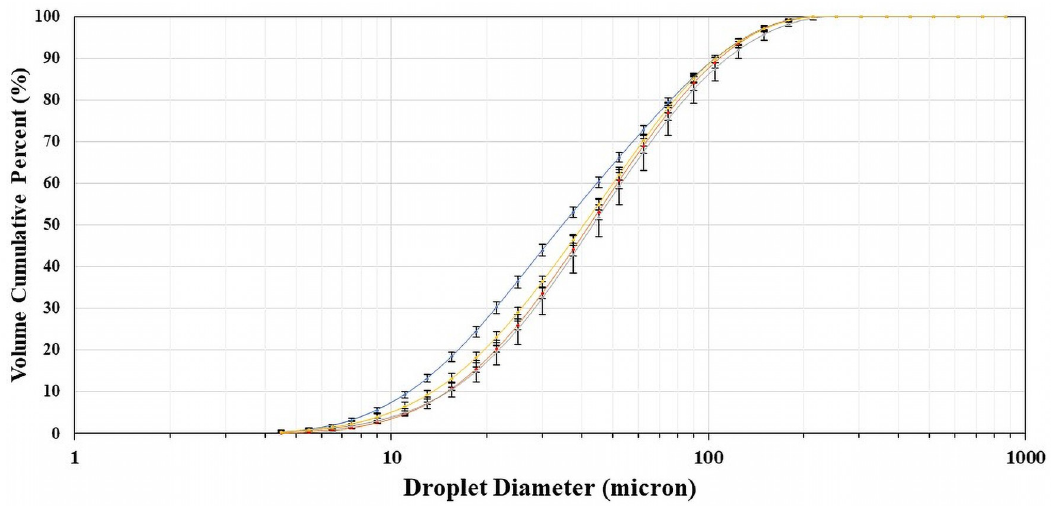
Fig 2. Cumulative size distributions by volume for the total 360 sprayer, at 6-foot distance, when spraying different liquids. Blue line = deionized water; red line = tap water; Grey line = disinfectant with dichlor as the active ingredient; Yellow line = disinfectant with hydrogen peroxide as its active ingredient.